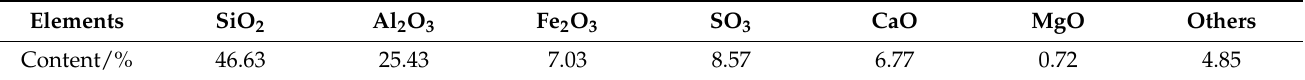
Table 1. Composition of main mineral